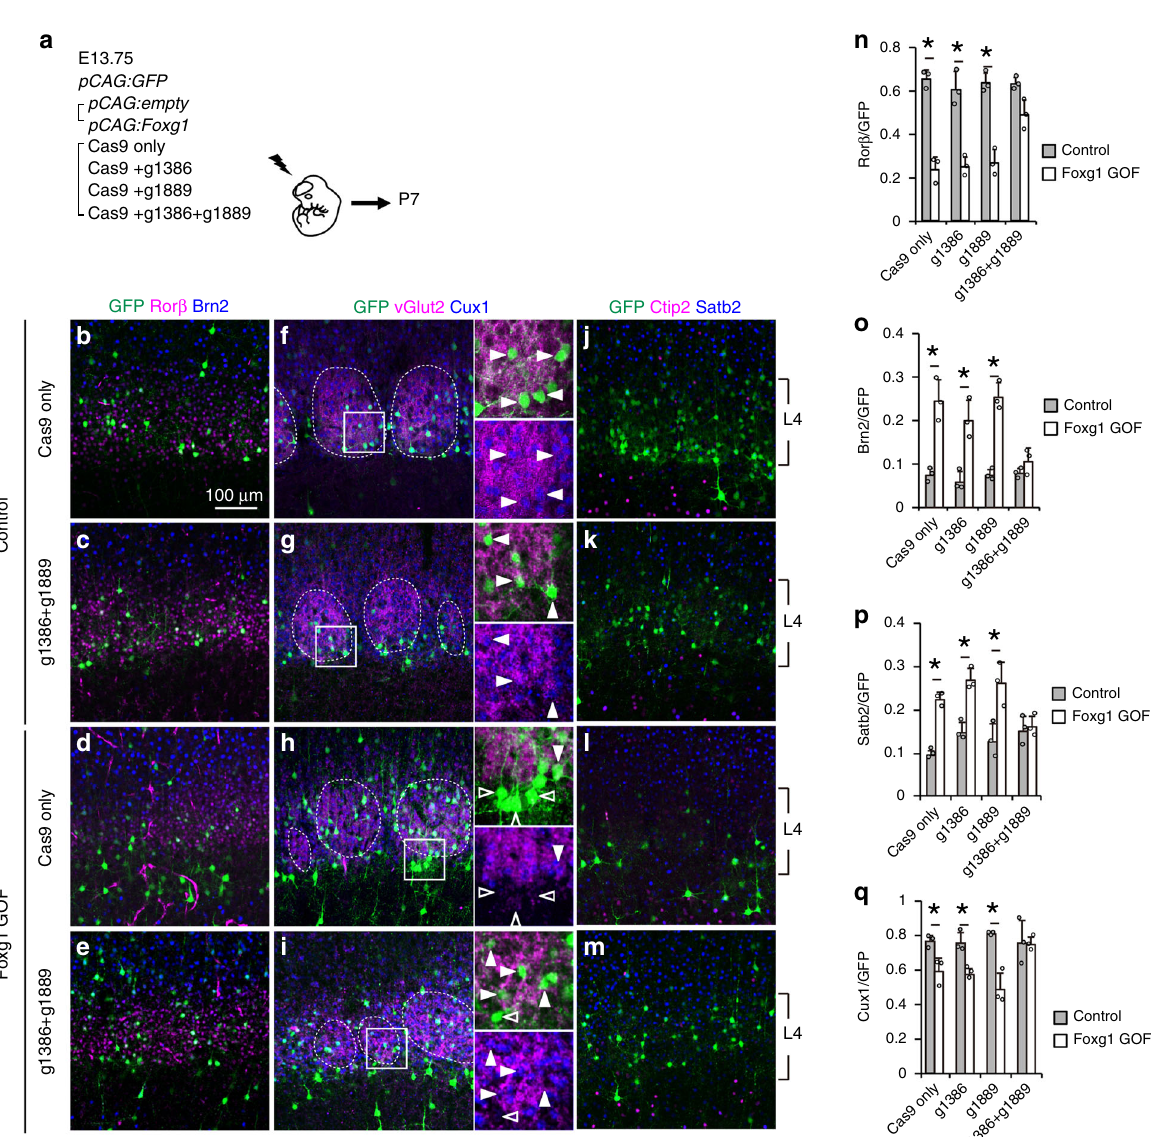
Fig. 5 Restoration of layer 4 fate upon removal of Foxg1 binding to COUP-TFI gene. a Schematic diagram of in utero electroporation. Brains were introduced with pCAG:GFP and pCAG: empty (Control) or pCAG:GFP and pCAG:Foxg1 (Foxg1 GOF). Combinations of gRNAs are as indicated. b – m Immunostaining of P7 cortices for GFP (green) with Ror β (red) and Brn2 (blue) ( b – e ), or vGlut2 (red) and Cux1 (blue) ( f – i ), or Ctip2 (red) and Satb2 (blue) ( j – m ). Dashed lines indicate layer 4 barrel structures. Closed arrowheads indicate GFP cells with enriched vGlut2 signal, thalamocortical presynaptic terminals and open arrowheads indicate GFP cells without enriched vGlut2 signal ( f – i ). n – q Quantitative analysis of the percentage (±SEM) of GFP cells that express Ror β ( n ), Brn2 ( o ), Satb2 ( p ), or Cux1 ( q ). * indicates P value <0.05 by Student ’ s t -test. Source data are provided as a Source Data fi